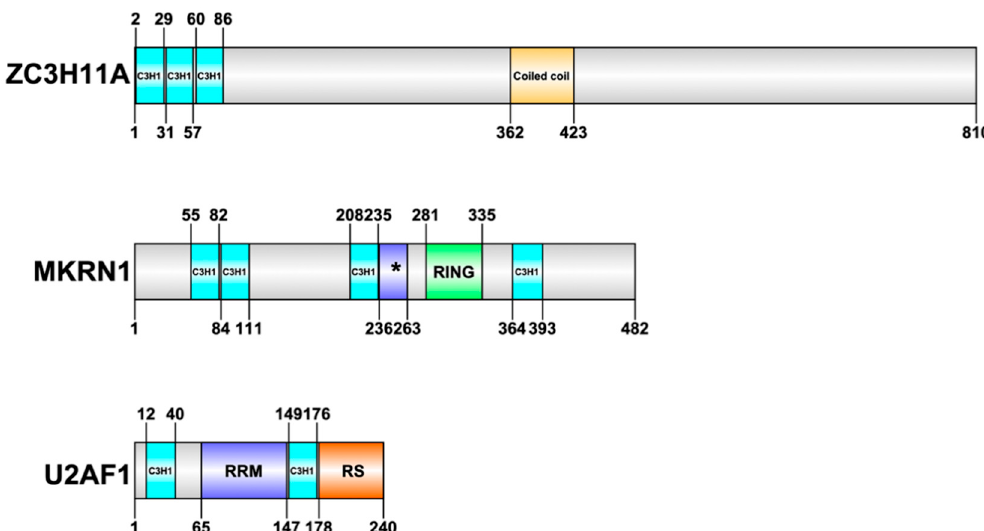
Figure 1. Structural overview of three CCCH-type zinc finger proteins: ZC3H11A (O75152), MKRN1 (Q9UHC7), and U2AF1 (Q01081). The domain labelling is based on Uniprot annotation